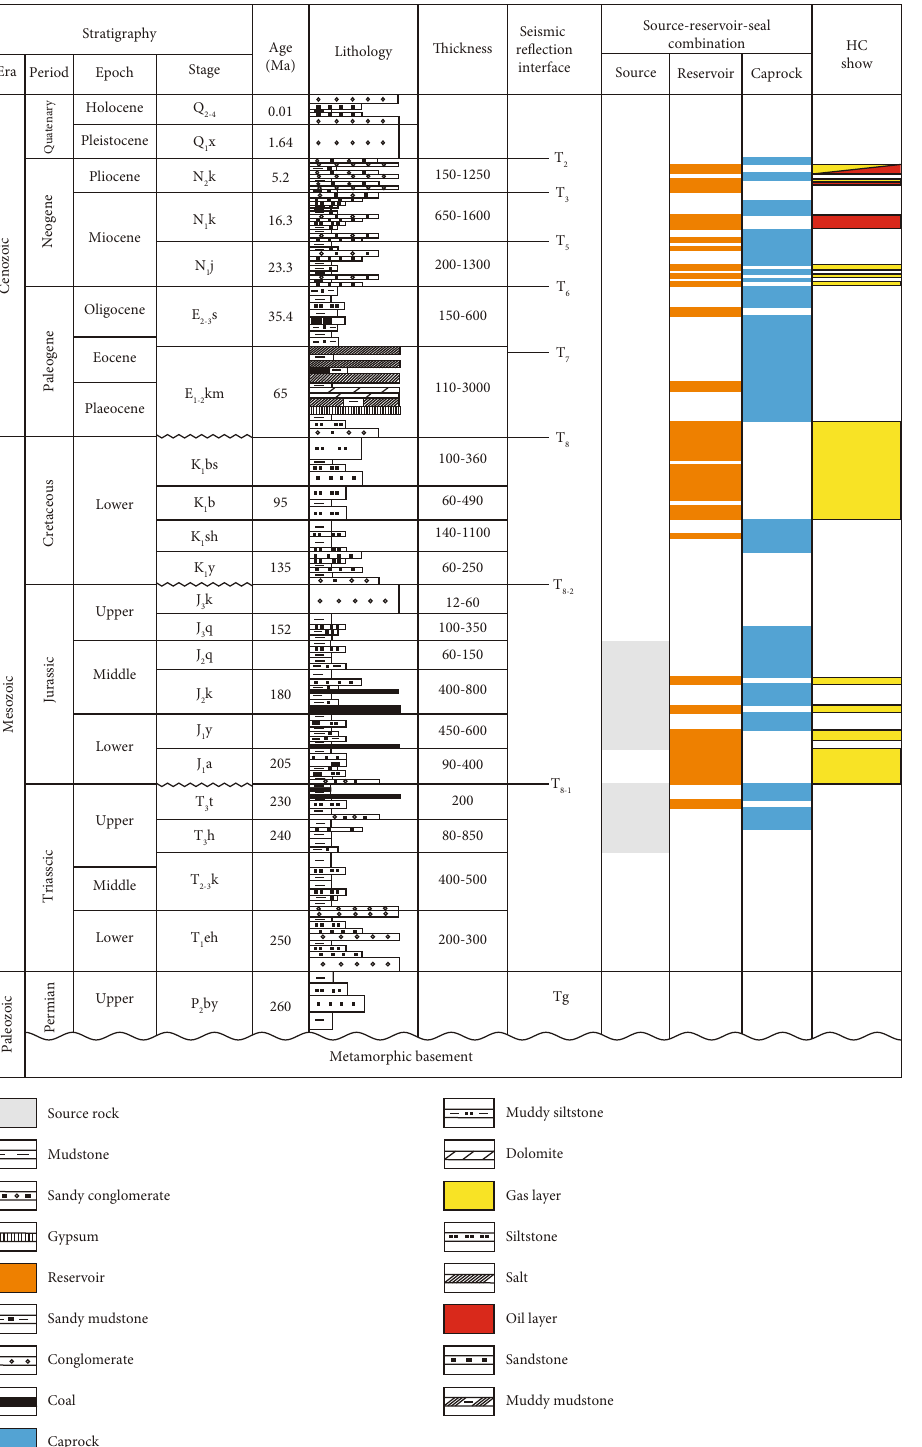
Figure 2: The integrated histogram of the Kuqa petroleum